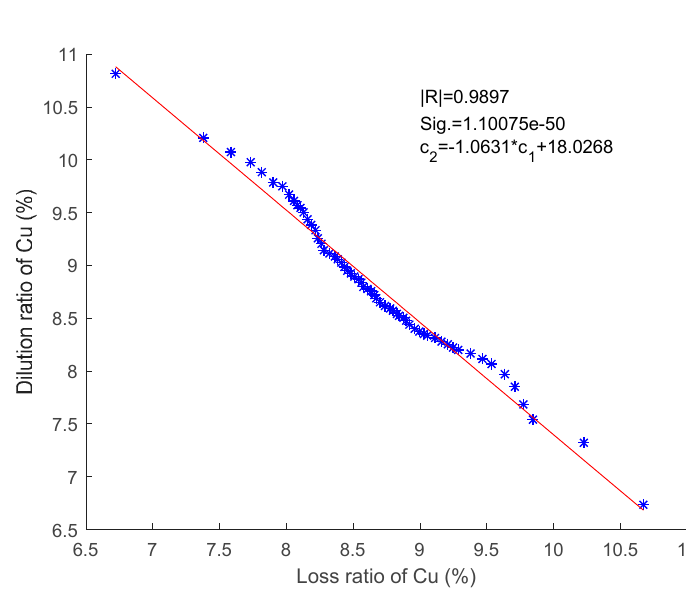
Figure 9. Linear fit of dilution ratio and loss ratio of Cu.